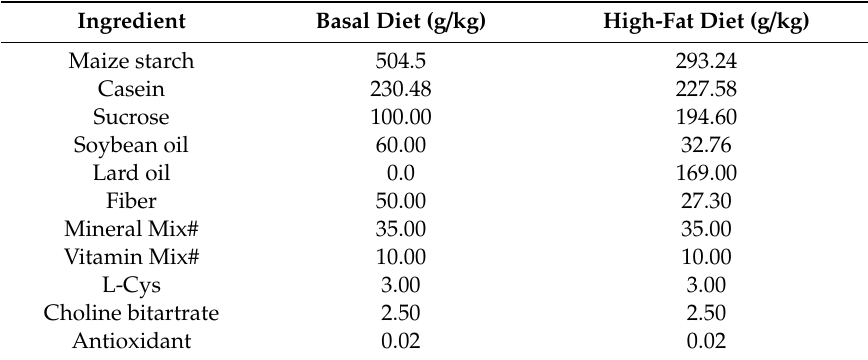
Table 1. The nutrition formula of diet